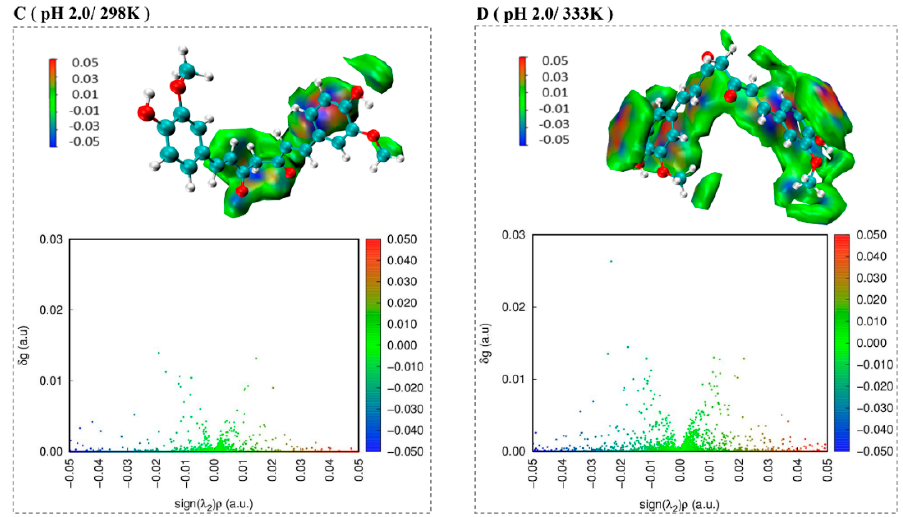
Figure 7. Gradient isosurface and scatter plot of the complex under different pH values and temperatures.